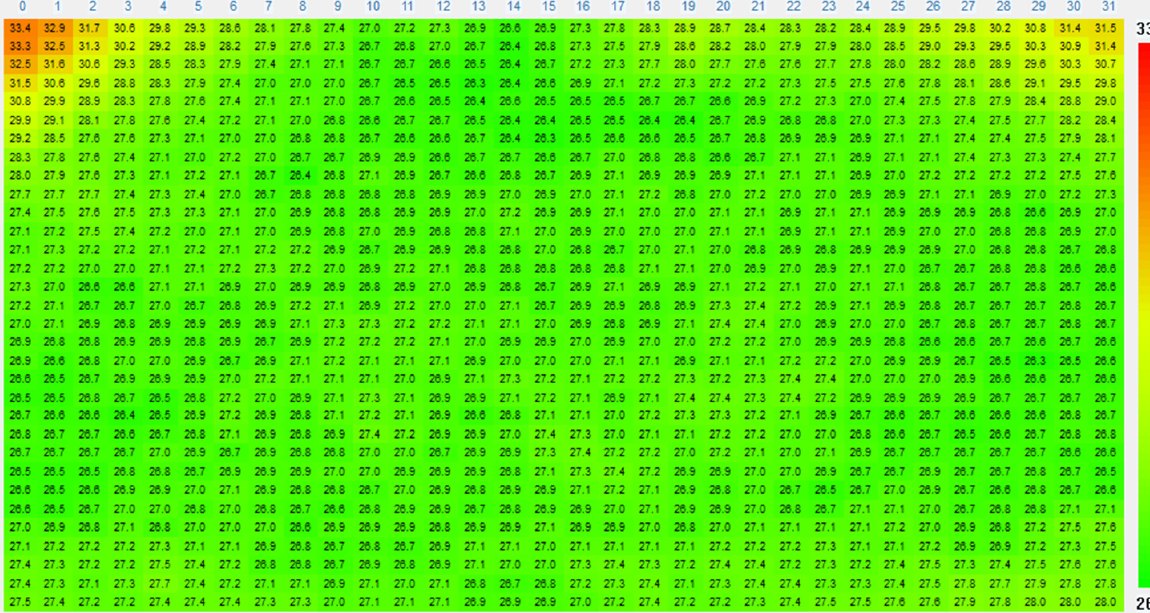
Figure 9. Thermal image of the thermopile MEMS IR array sensor.